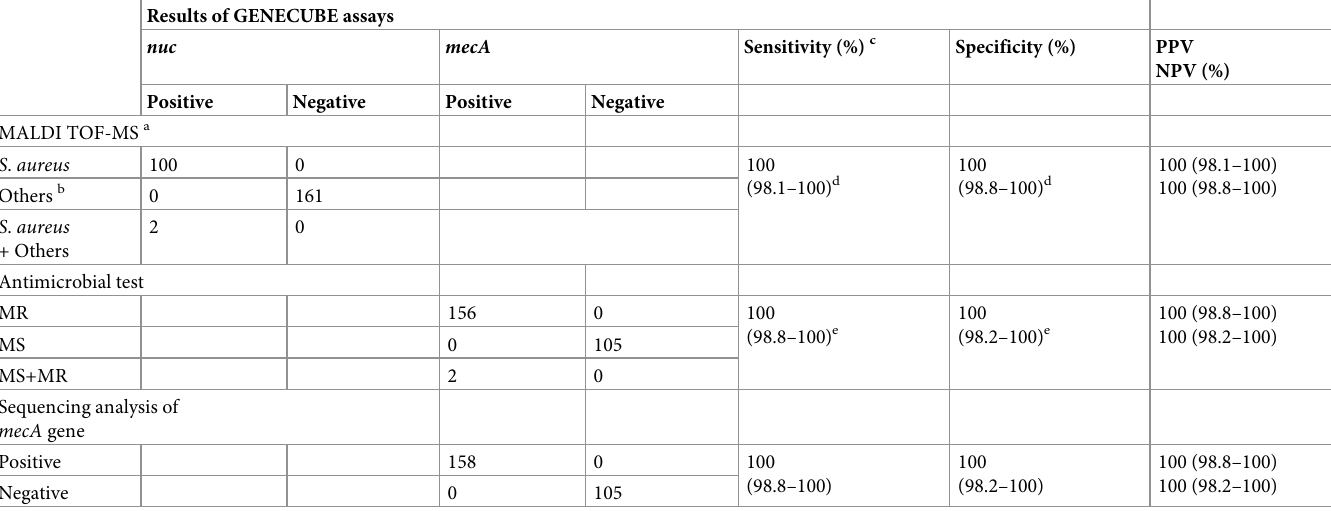
Table 5. Agreement between results from the GENECUBE and microbiological assays.